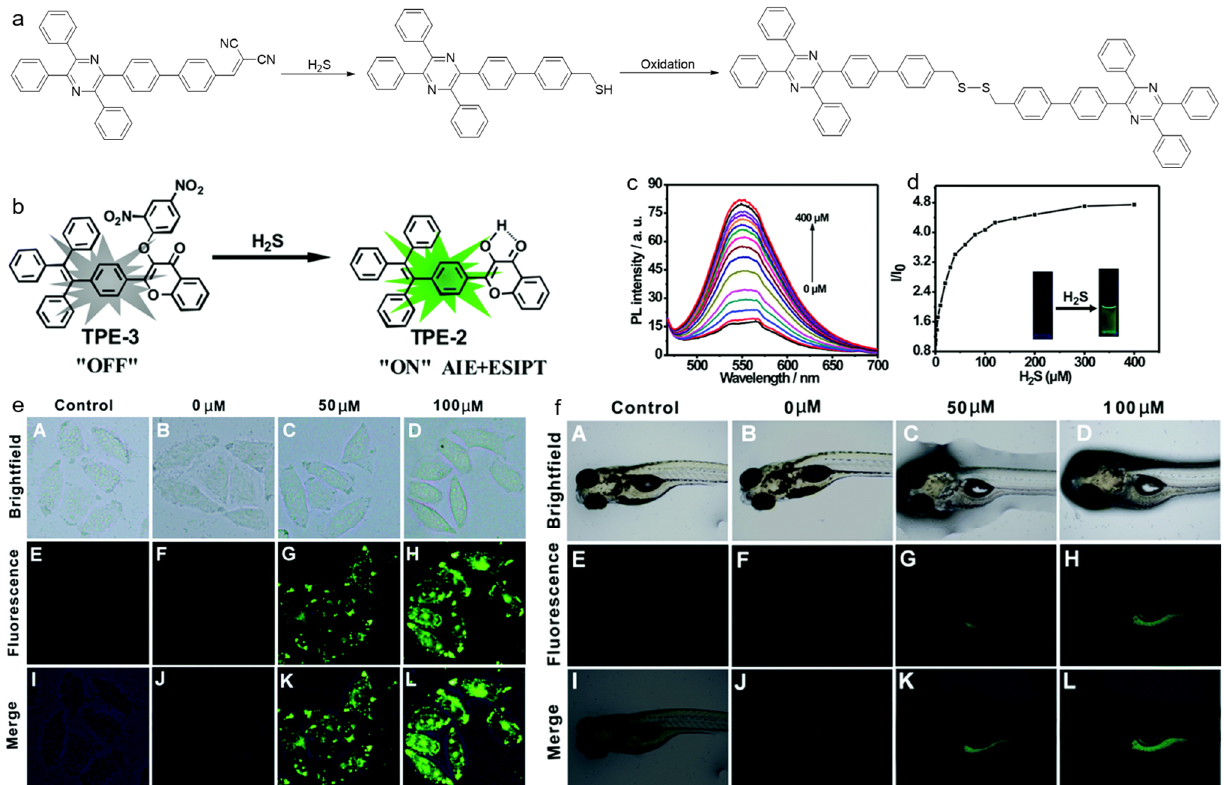
Figure 17. ( a ) The proposed reaction process of TPP-PDCV for detecting H 2 S; ( b ) the AIE probe for H 2 S detection with turn-on fluorescence; ( c ) PL spectra and ( d ) the corresponding PL intensity ratio of the AIE probe treated with different concentrations of H 2 S; Fluorescence imaging of ( e ) HeLa cells and ( f ) zebrafish larvae treated with different concentrations of H 2 S. (Reproduced with the permission from ref. [171]. Copyright 2016, The Royal Society of Chemistry and the Chinese Chemical Society).